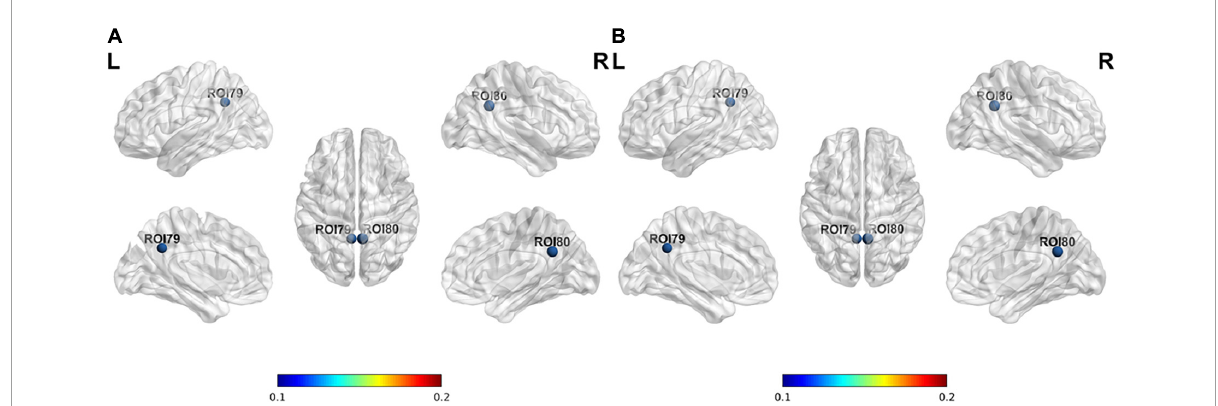
FIGURE3 Differences in node properties between patients with T2DM and HC. (A) Nodal degree centrality; (B) nodal efficiency.